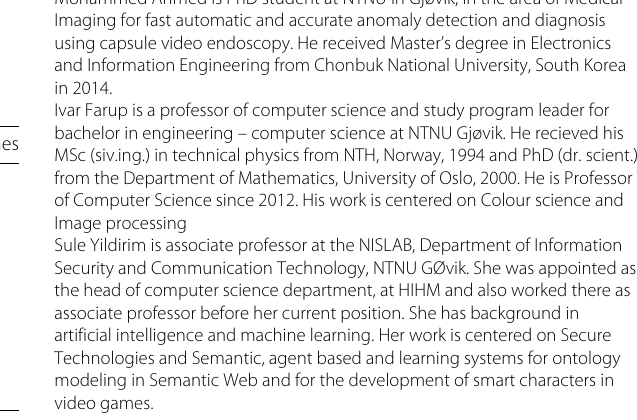
give a better diagnostic value by reducing eye fatigue. We proposed a variational approach to CCE frame motion